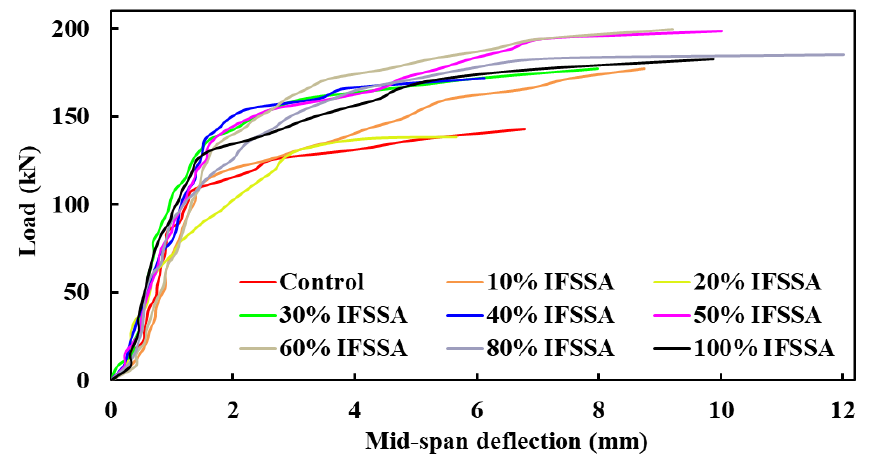
Figure 5. Load-deflection curve of beams made with different percentages of IFSSA.